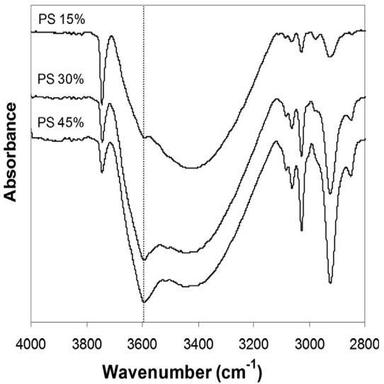
FTIR-ATR spectra of S(100)48-PS composite samples.